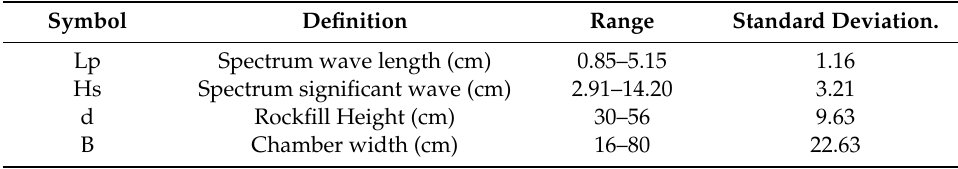
Table 1. Ranges of principal experimental parameters.